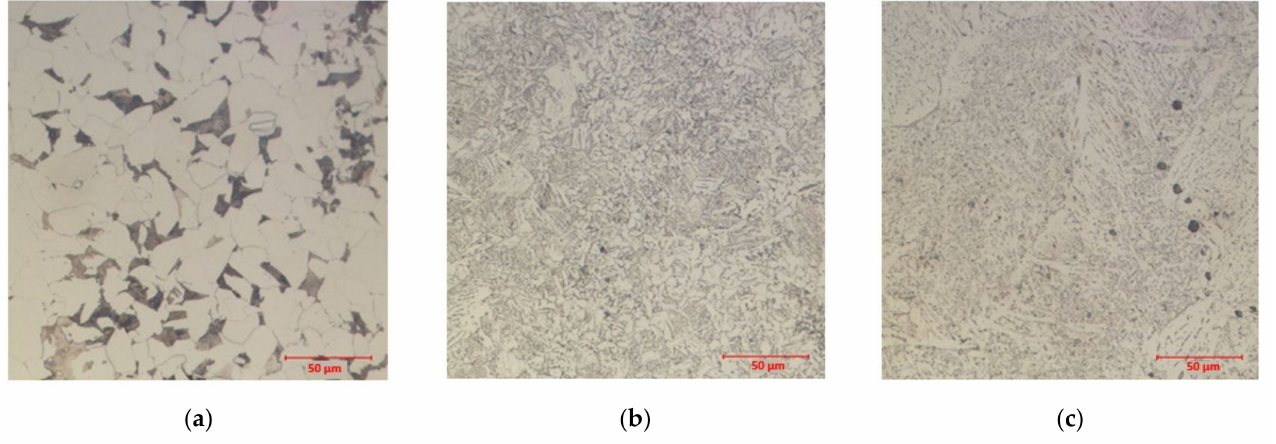
Figure 13. Microstructure of the heat-treated specimen at 590 ◦ C. ( a ) Parent material; ( b ) HAZ; and ( c ) weld